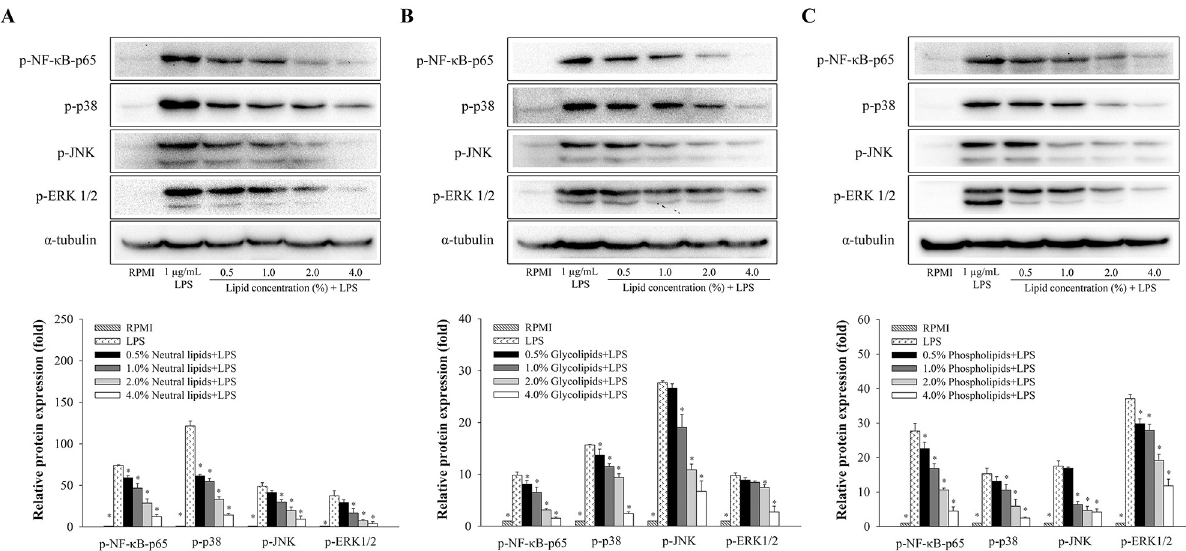
Fig 4. The effects of fractionated lipids from H . aurantium tunic on the protein expression associated with NF- κ B and MAPK pathways in LPS- stimulated RAW264.7 cells. (A) Western blot and relative band of neutral lipids. (B) Western blot and relative band blot of glycolipids. (C) Western blot and relative band of phospholipids. Significant different at p < 0.05 ( � ) compared with